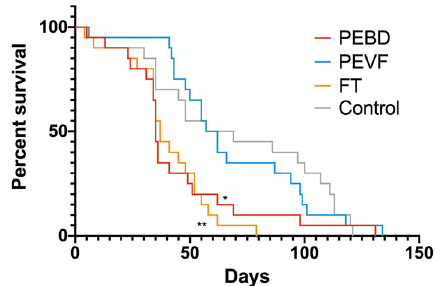
Figure 6. The survival of D. magna after exposure to one initial dose of the HDPE breakdown fractions. D. magna was exposed to a single dose of the different breakdown fractions. The PEVF contains, in addition to nano-sized plastics, approximately 20% FT. Asterisks indicate significant difference from a control group, *p < 0.05, **p < 0.01.